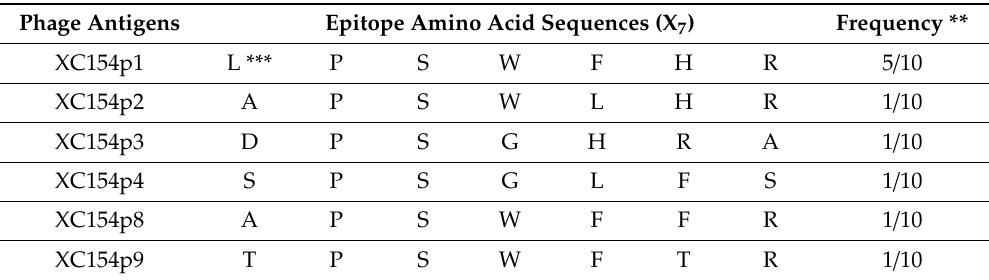
Table 2. Epitope peptide sequences (C-X 7 -C *) of selected